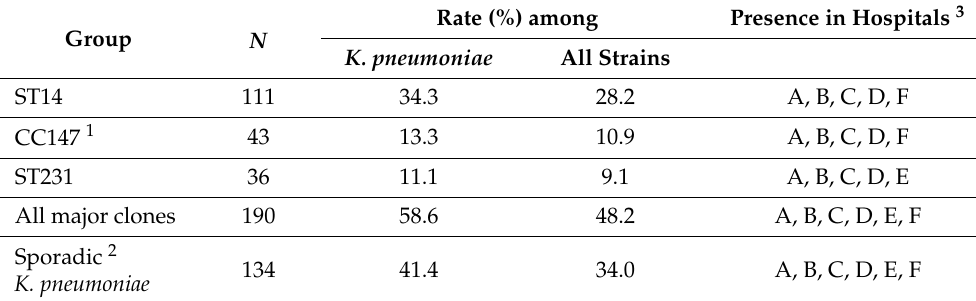
Table 2. Rate and distribution of major Klebsiella pneumoniae clones encountered between 2009 and